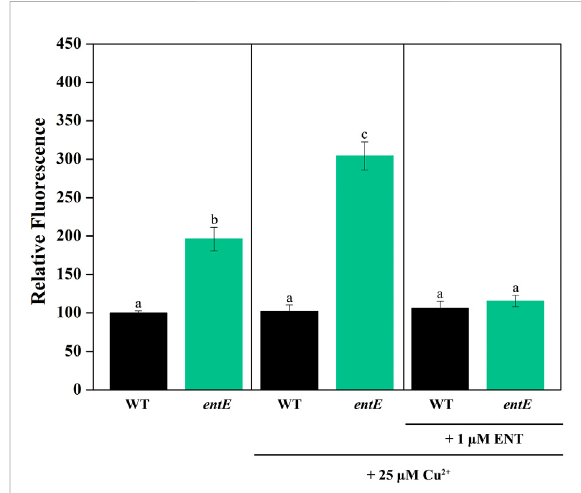
FIGURE 3 Measurement of ROS levels in E. coli wild-type and entE mutant. Impact of copper and enterobactin addition. Determination of ROS levels in wild-type (WT) and entE strains, grown in M9 with no copper added (left panel), with 25 µM of CuSO 4 (central panel) and, with 25 µM CuSO 4 plus 1 µM of enterobactin (right panel). Results are expressed as relative fl uorescence to that of the control corresponding to WT strain grown in M9 medium. Values are means ± SD for three independent experiments. Statistically signi fi cant differences betweenanytwoconditionscomparedareindicatedwithdifferent letters ( p < 0.05). Same letters indicate no statistically signi fi cant